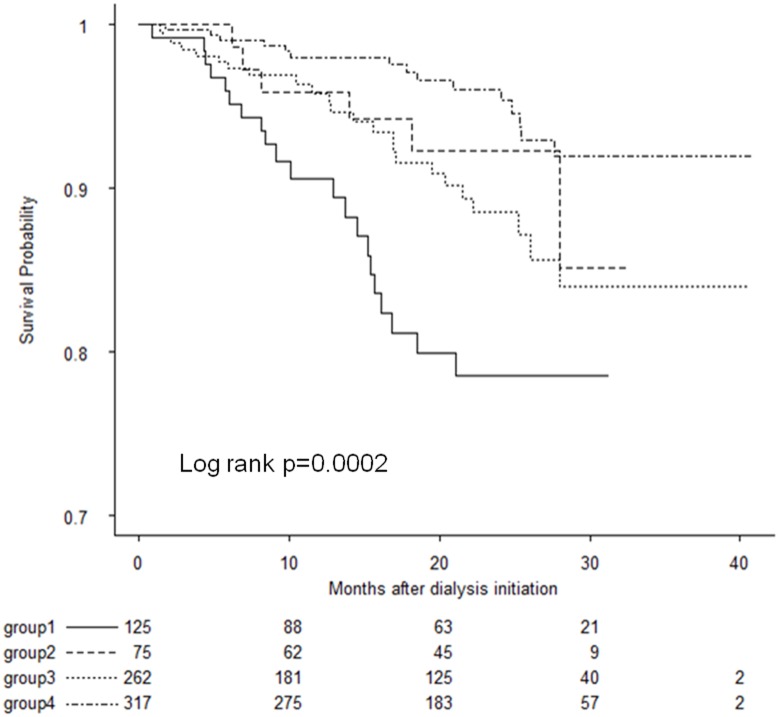
Survival probability according to time-dependent Hb and time-dependent erythropoiesis-stimulating agent dose categories in all the patients.Group 1, Hb < 10 g/dL and ESA ≥ 126 U/week/kg; group 2, Hb < 10 g/dL and ESA < 126 U/week/kg; group 3, Hb ≥ 10 g/dL and ESA ≥ 126 U/week/kg; and group 4, Hb ≥ 10 g/dL and ESA < 126 U/week/kg.